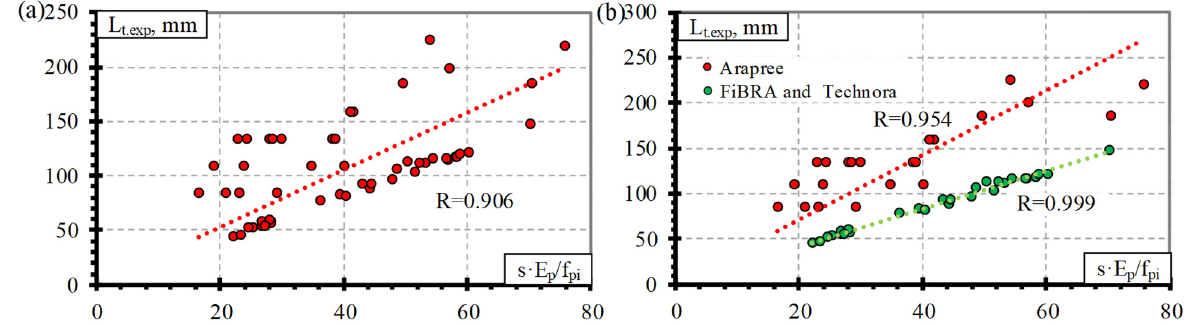
Figure 6. Comparison between the transfer length of the AFRP bars and s·E p /f pi : ( a ) all results, ( b ) effect of the type of reinforcement.